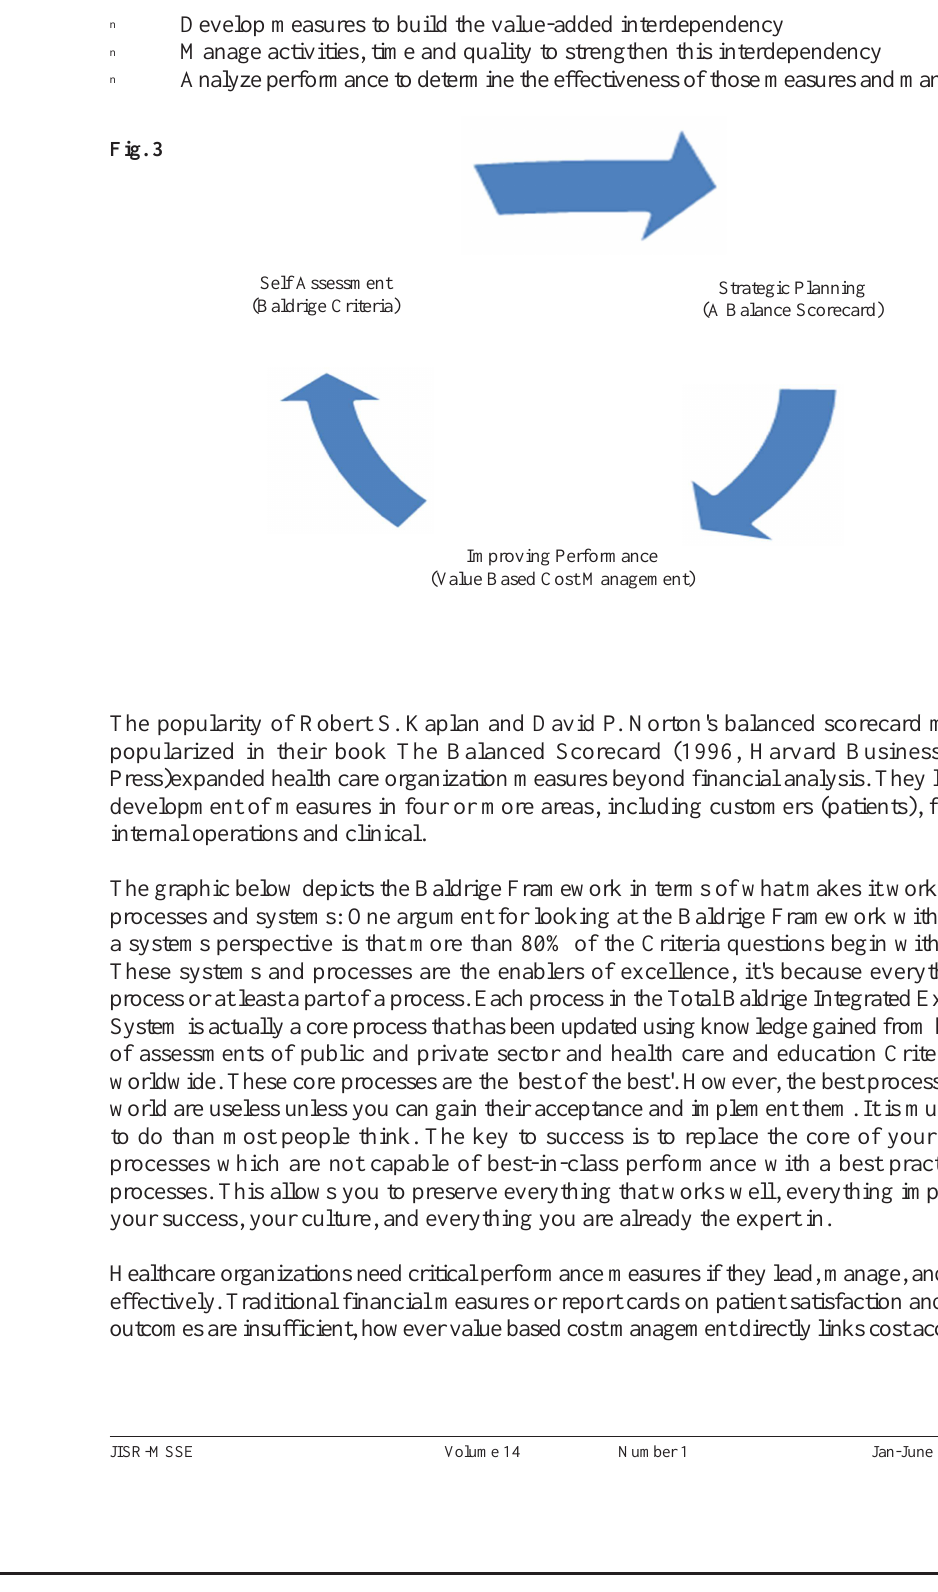
n Develop measures to build the value-added interdependency n Manage activities, time and quality to strengthen this interdependency n Analyze performance to determine the effectiveness of those measures and management